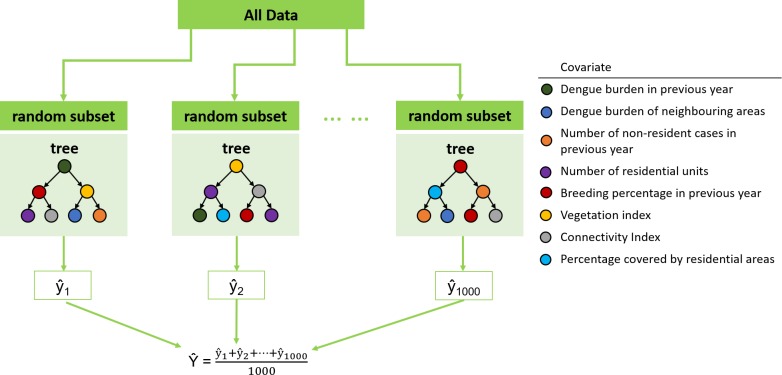
Framework of random forest algorithm.1000 random bootstrap samples were drawn from the data, and an unpruned decision tree is fitted to each bootstrap sample. At each node, a small subset of the covariates was chosen at random to optimize the split. The predicted risk rank is obtained by averaging the prediction of all trees.